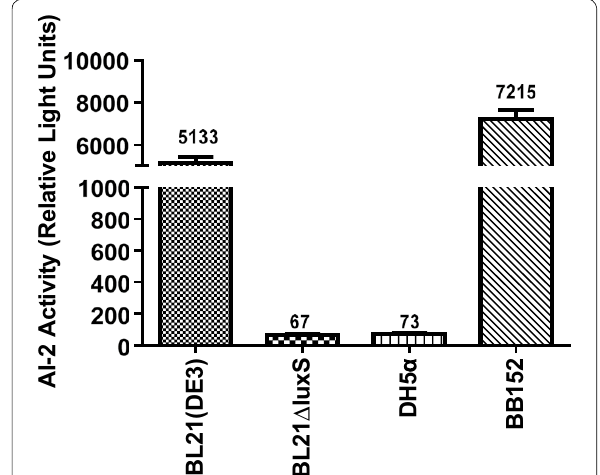
Fig. 2 The AI-2 activity in BL21∆luxS. The wild strain BL21 secretes AI- 2-like molecules, and can induce V . harveyi BB170 bioluminescence, whereas no bioluminescence induction was observed for the mutant BL21∆ luxS . V . harveyi BB152 served as a positive control and E. coli DH5α as a negative control. The figure represents the means of the results from three independent experiments. The error bars indicate standard